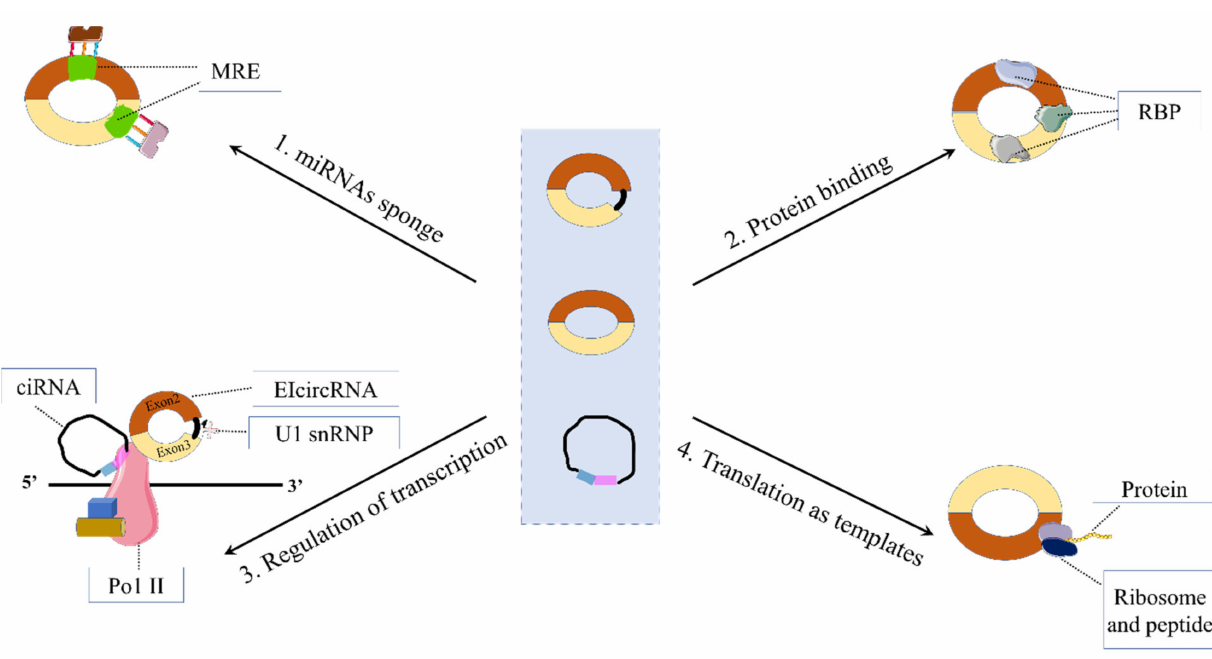
Figure 2. Functions of